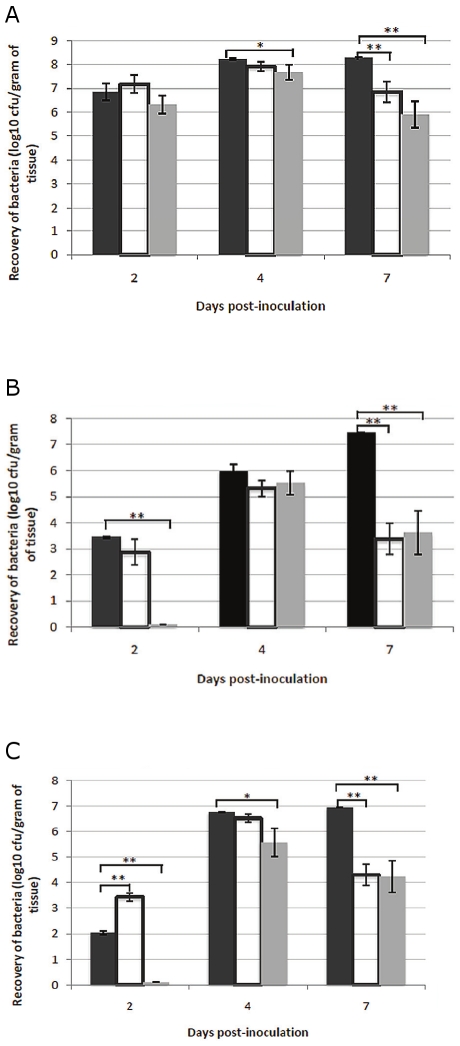
Recovery of F. tularensis LVSΔ1423/1422 from the tissues of mice following IN inoculation.Groups of BALB/c mice were inoculated IN with 7.9×103 CFU of strain LVS, 5.0×104 CFU of strain LVSΔ1423/1422 (high dose of mutant), or 1.1×104 CFU of strain LVSΔ1423/1422 (low dose of mutant). At 2, 4, or 7 days PI, mice were euthanized. The lungs (A), liver (B), and spleen (C) were aseptically removed, homogenized in PBS, and the CFU/g of tissue determined. The recovery of bacteria from inoculated mice are shown as dark-filled bars (LVS), open bars (high dose of LVSΔ1423/1422), and grey-filled bars (low dose of LVSΔ1423/1422). The mean values of the CFUs of each dose of the mutant were separately compared with LVS. The P values for the differences between the mean values were <0.05 (*) or <0.005 (*).